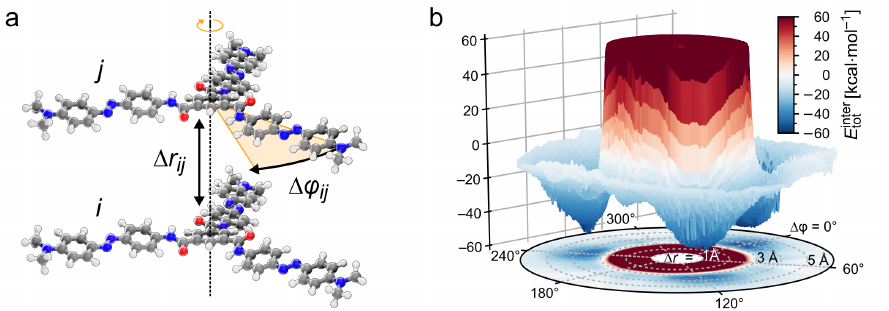
Figure 2. ( a ) Geometrical variables considered for the analysis of the intermolecular energy: pairwise distance ∆ r ij and rotation angle ∆ ϕ ij between a pair i and j of TrisAzo . ( b ) Three-dimensional energy landscape (total intermolecular energy) of a TrisAzo dimer. The energies are depicted in a range of colors: blue—negative, grey—zero, red—positive. Positive energy values beyond 60kcal · mol − 1 are not shown. The absence of data for ∆ r < 1Å is indicated by an empty (white)